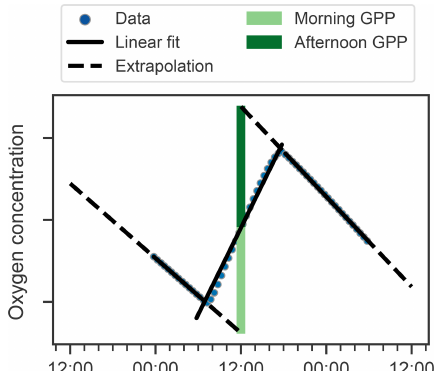
Figure 5. Schematic showing method for calculating GPP and R us- ing oxygen data (points) after Briggs et al. (2018). Respiration rates are determined as nighttime slopes (solid black lines), which are then projected forward and backward in time (dashed black lines). The differences between these projections and oxygen at noon ob- served yields the morning and afternoon GPP (light and dark green bars